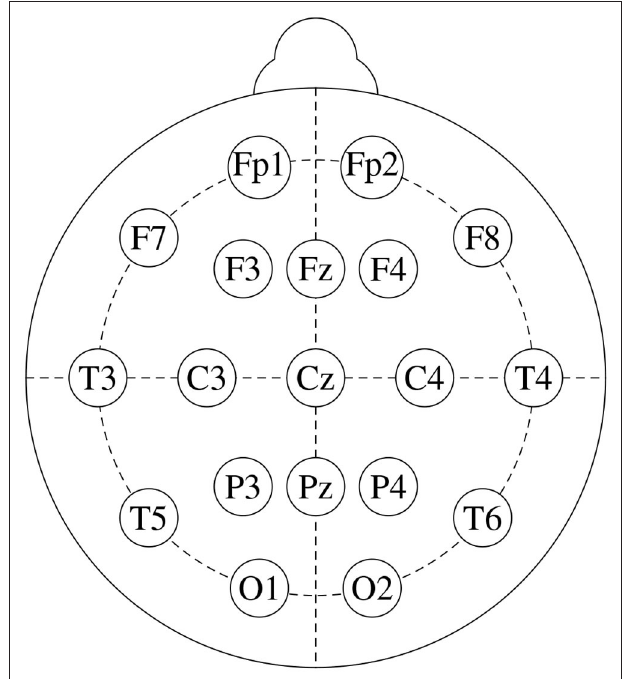
FIGURE 1 | Standard 10-20 EEG setup, that consists of 19 channels: Fp1, Fp2, F7, F3, Fz, F4, F8, C3, Cz, C4, P3, Pz, P4, T3, T4, T5, T6, O1, and